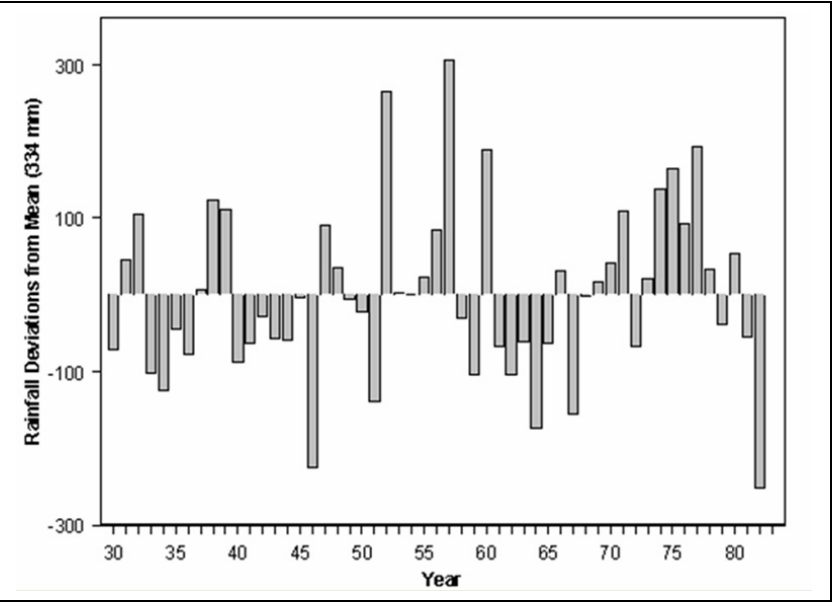
Figure 5. Difference from the mean annual rainfall recorded at Beitbridge, Matabeleland South Province, Zimbabwe, located on the Limpopo River at the border with South Africa, from 1931 to